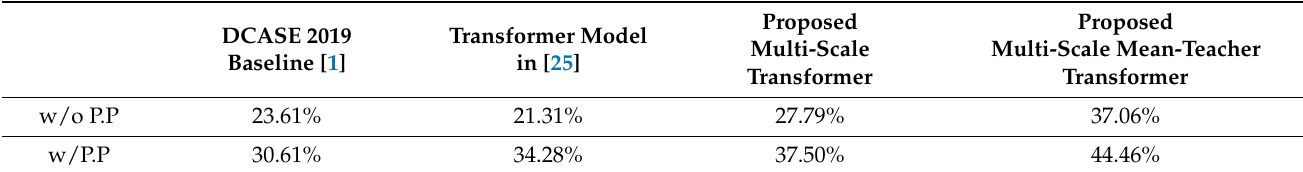
Table 7. Comparison of event-based SED results in F-score on validation data of the proposed multi-scale Transformer models with the baseline system of DCASE 2019 [1] and the Transformer model in